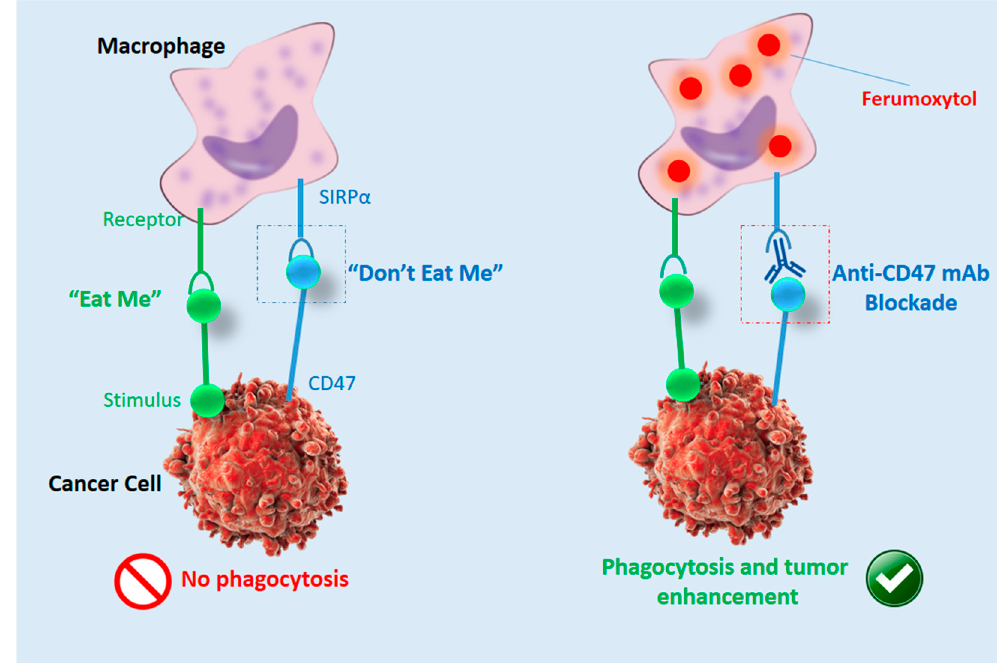
Figure 2. Schematic illustration of ferumoxytol-MRI as an imaging approach for CD47 immunotherapy, reproduced from [86].